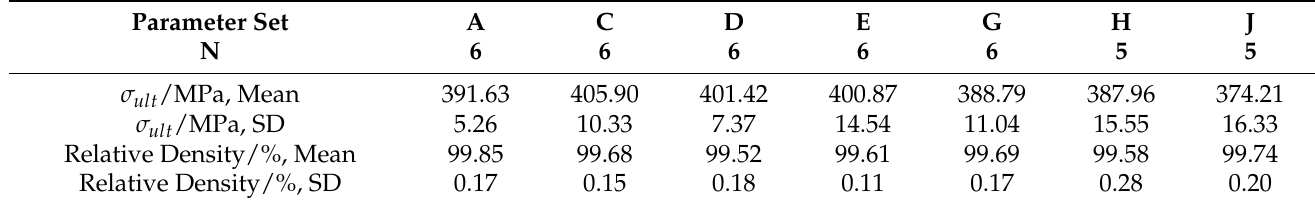
Table A2. Ultimate tensile strength and relative density of tensile samples. Reference density 2.68 g/cm 3 . Seven surface